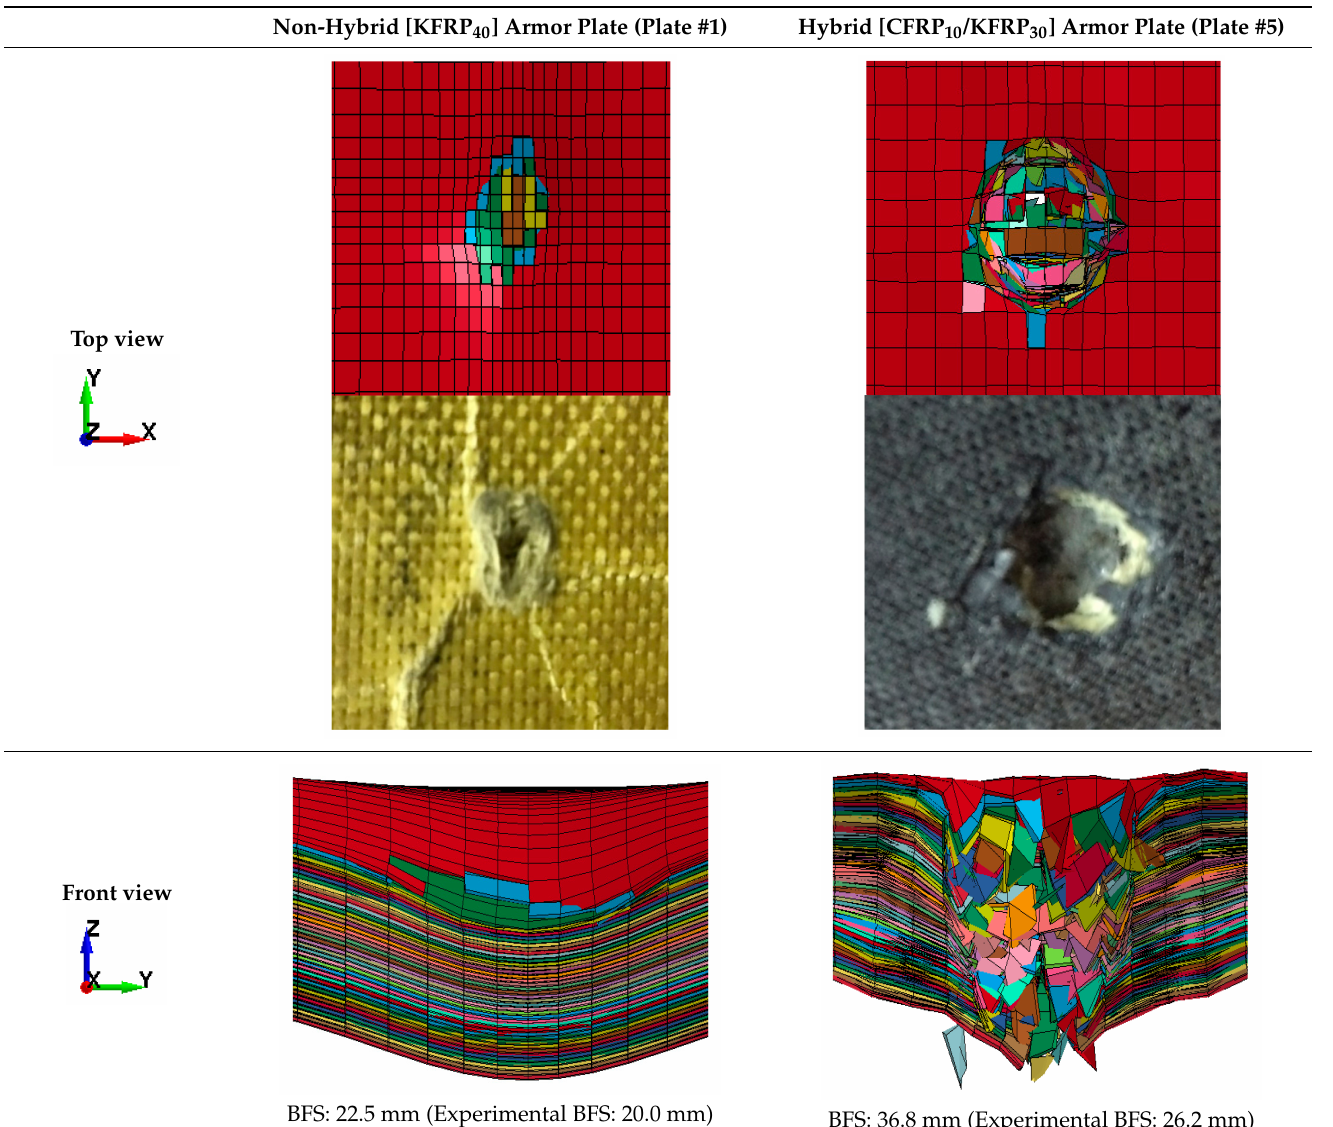
Table 5. Comparison between experimental and numerical strike faces (top views) and back-face signature (BFS) (front view) for the flat non-hybrid [KFRP 40 ] and the flat hybrid [CFRP 10 /KFRP 30 ]